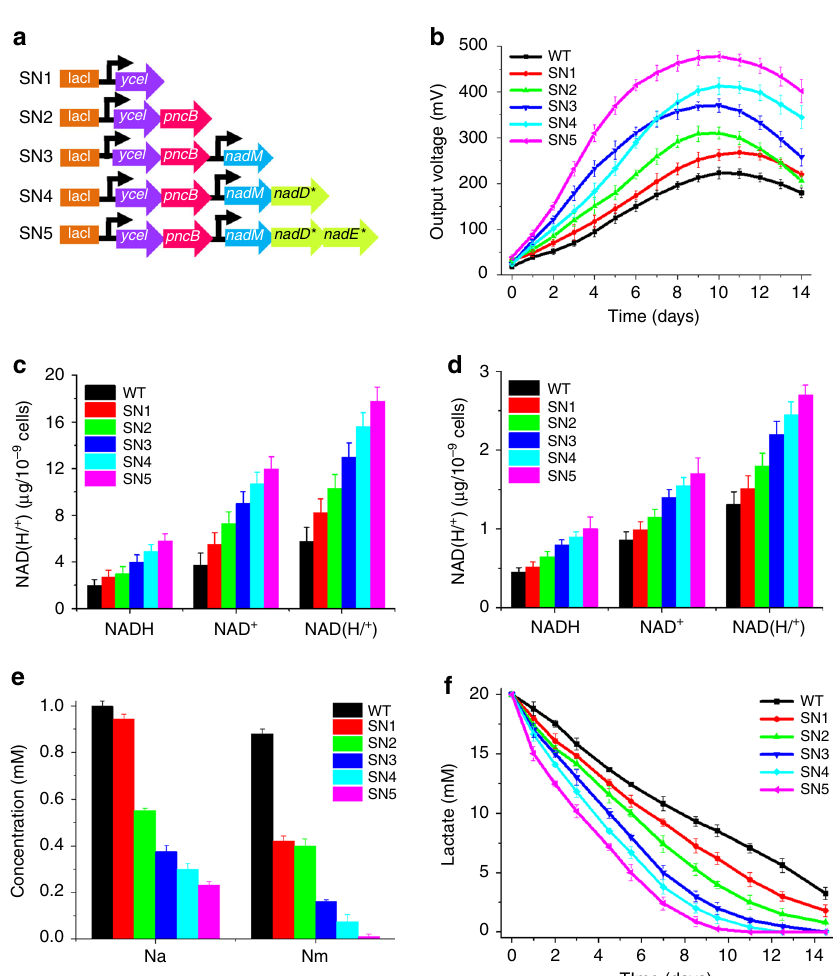
Fig. 5 Modular assembly of the fi ve crucial genes for enhanced NAD + biosynthesis to increase the extracellular electron transfer (EET) rate. a A depiction of the plasmids that incorporated the modular assemblage of the fi ve crucial genes ( ycel , pncB , nadM , nadD* , and nadE* ) identi fi ed from the three modules (Module-1, -2, and -3), which had a signi fi cant impact on NAD + biosynthesis. b Voltage output in MFCs of the S. oneidensis recombinant strains programmed with the above plasmids, respectively. c Quantitative measurements of the intracellular NAD + , NADH, and total NAD(H/ + ) levels of these recombinant strains in anaerobic cultures. d Quanti fi cation of intracellular NAD + , NADH, and total NAD(H/ + ) levels of these recombinant strains in MFCs after discharge. e Nicotinic acid (Na) and nicotinamide (Nm) concentrations in the MFCs anolytes of the recombinant S. oneidensis strains. f Lactate consumption in the MFCs inoculated with these S. oneidensis recombinant strains programmed with the above plasmids SN1 – SN5,